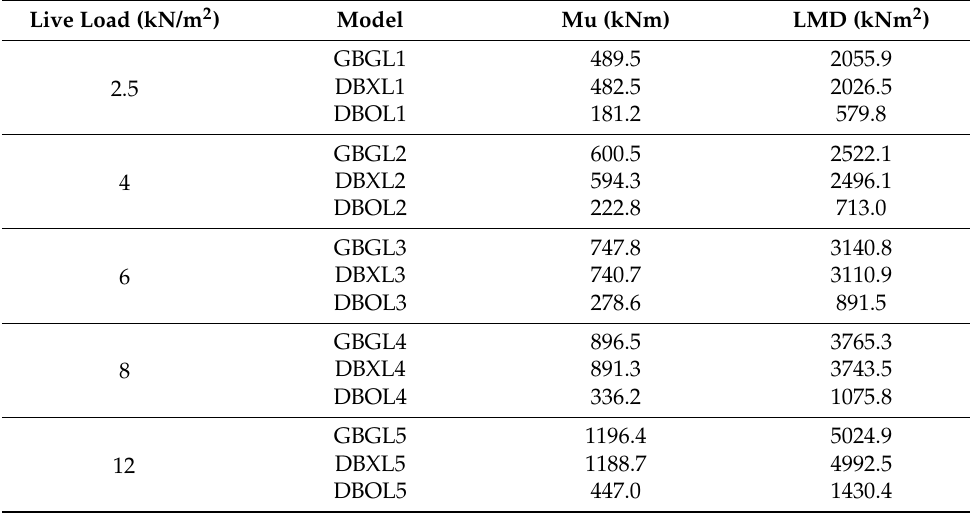
Table 2. Results of moment demands and LM index in terms of demand for the main beam or double-beam from frame